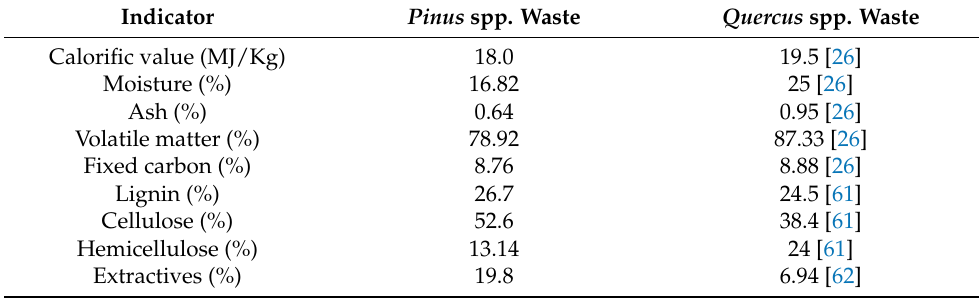
Table 6. Evaluation of the